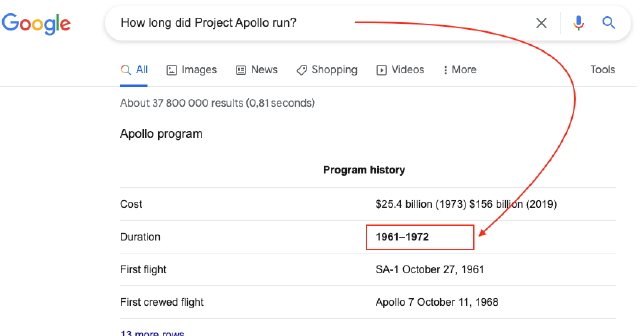
Figure 1. An example of Google search engine with machine reading comprehension